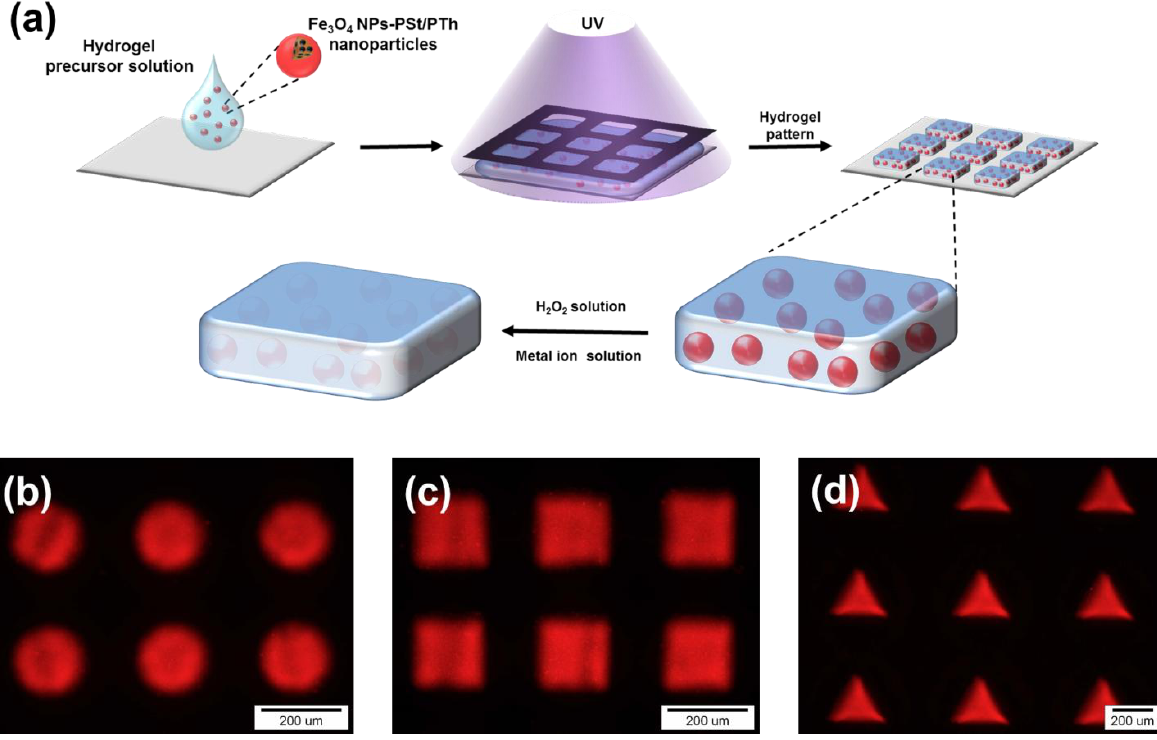
Figure 7. ( a ) Fluorescence micrographs of Fe